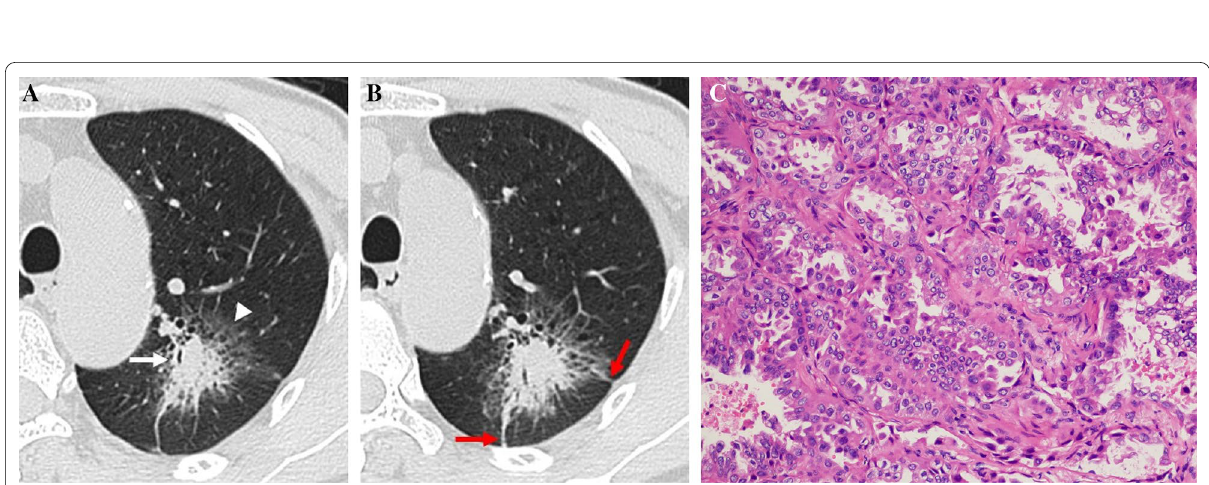
Fig. 3 L‑PLADC in a 68‑year‑old man without symptoms. A and B Axial CT images of lung window indicate a localized consolidation with irregular air bronchogram (white arrow), GGO component (white arrowhead), and pleural retraction (red arrow) in the left upper lobe. C Photomicrograph (hematoxylin and eosin staining, 200) confirmed LADC with an acinar‑predominant ×